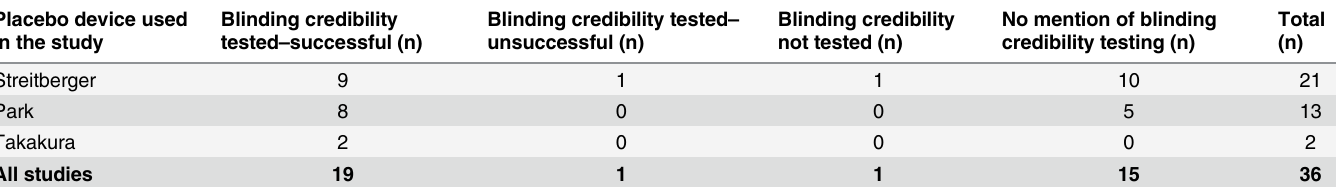
Table 6. Author reported blinding credibility